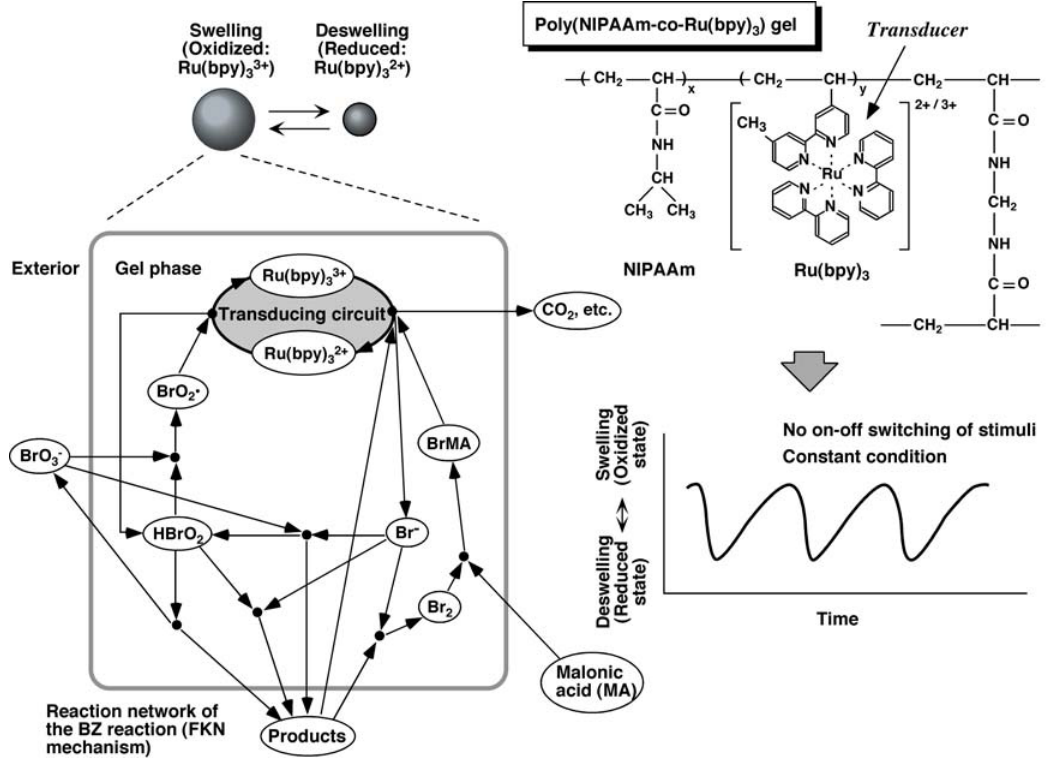
Figure 1. Mechanism of self-oscillation for poly(NIPAAm-co-Ru(bpy) 32+ ) gel coupled with the Belousov-Zhabotinsky